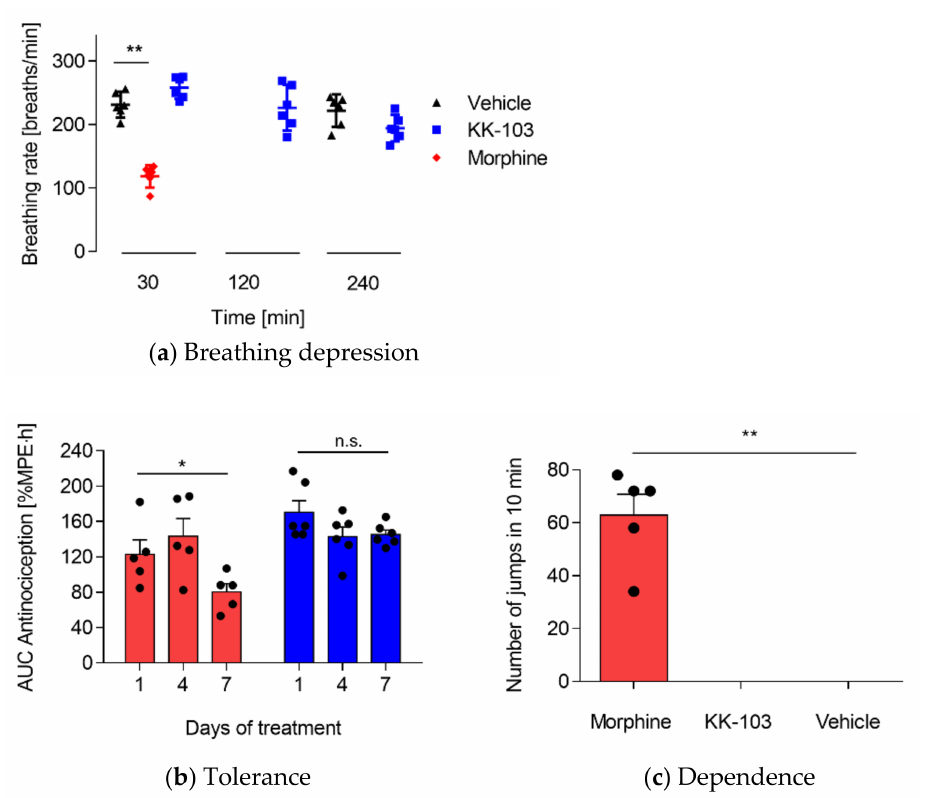
Figure 6. Safety profiles of KK-103 (s.c., 13 mg/kg) compared to morphine (s.c., 10 mg/kg) in female CD-1 mice. ( a ) Breathing effect of KK-103 and morphine were compared to vehicle at different time points after drug administration. ** p < 0.001 compared to vehicle. ( b ) Antinociceptive tolerance measured by the hot-plate test. Mice received twice-daily treatments for 7 consecutive days. The analgesic activity was measured on days 1, 4, and 7, * p < 0.01 (morphine day 1 vs. day 7), n.s. denotes not significant (KK-103, day 1 vs. day 7). ( c ) Physical dependence in mice after receiving twice-daily treatments for 8 days. Two hours post the final dose, mice received Nlx (i.p., 4 mg/kg) and the number of jumps within the first 10 min were measured. ** p < 0.001 compared to vehicle Data = mean ± 95% confidence interval ( n = 10) for panel ( a ) and data = mean ± SEM ( n = 6) for panels ( b , c ). Statistical comparisons were performed using one-way ANOVA with Tukey post hoc test for the 30 min time point and two-tailed unpaired t-test for 120 and 240 min ( a ), one-way ANOVA with Tukey post hoc test ( b , c